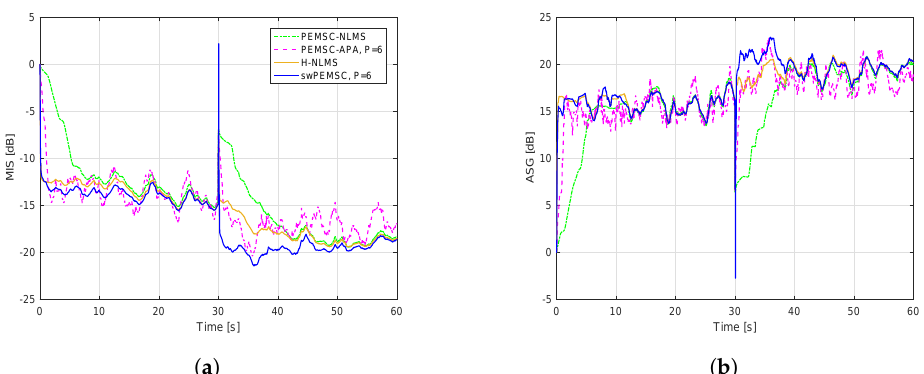
Figure 13. Performance of the proposed method state-of-the art AFC methods using music input, a sudden change of the feedback path from free-field ( F 1 ) to telephone-near ( F 2 ) after 30 s: ( a ) MIS; ( b ) ASG.